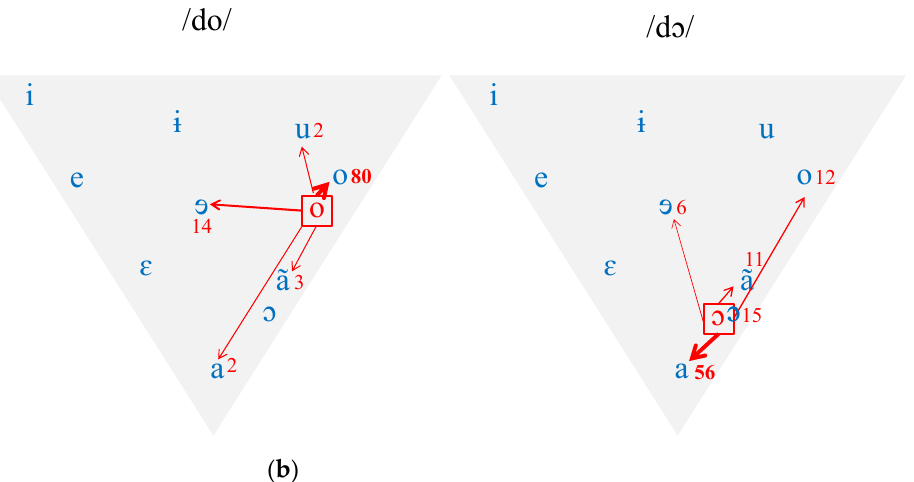
Figure 3. The percentage of Hñäñho words categorized as containing Hñäñho vowels by Hñäñho heritage speakers (HHS): ( a ) the/a - ɔ /vowel contrast; ( b ) the/o - ɔ /vowel contrast.